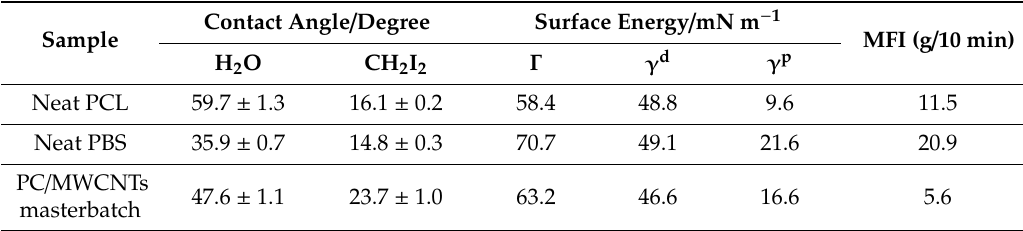
where γ (cid:2869)(cid:2870) = interfacial tension between components 1 and 2 in the blend, γ (cid:2869) and γ (cid:2870) are the total surface energies of components 1 and 2, γ (cid:2869)(cid:3031) and γ (cid:2870)(cid:3031) are the dispersive surface energies of components 1 and 2, and γ (cid:2869)(cid:3043) and γ (cid:2870)(cid:3043) are the polar surface energies of the components in the nanocomposites. The wetting coefficient, w α , is calculated by using Equation (4).